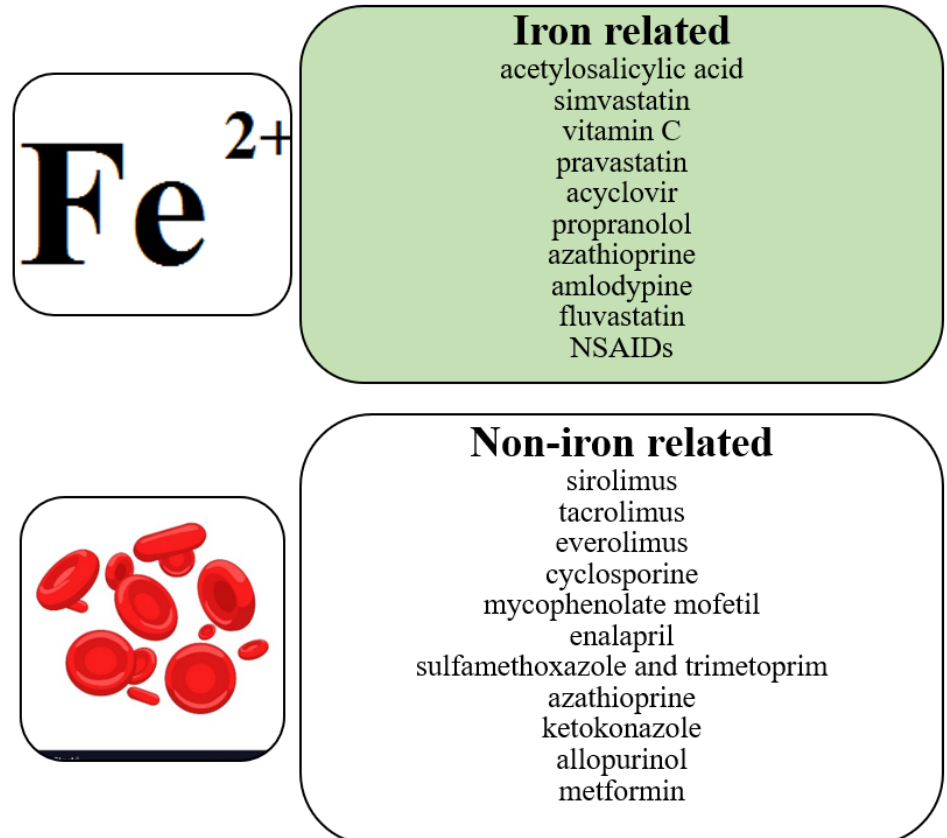
Figure 2. Correlation between pharmacotherapy and anemia.